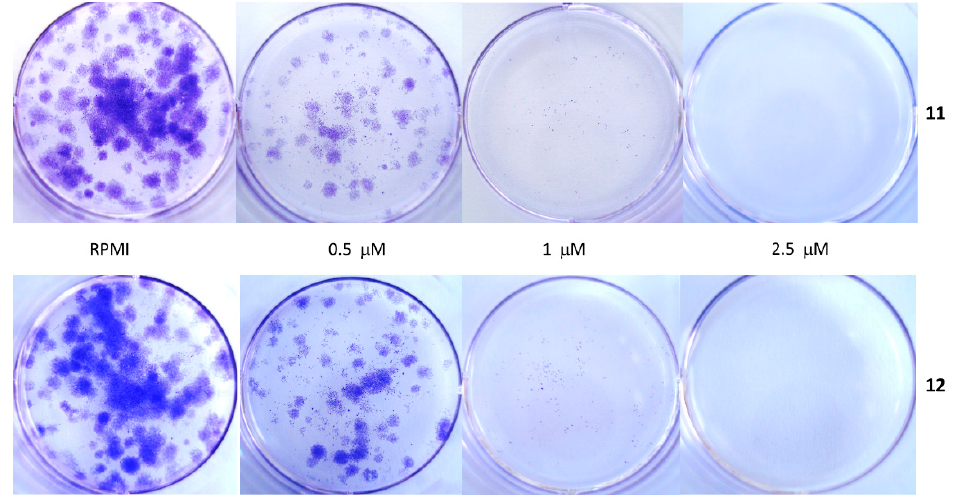
Figure 4. Clonal growth inhibition. Effects of 11 and 12 on the clonal growth of SK melanoma cells. Cells were suspended in a medium containing the indicated increasing concentrations of 11 and 12 for 4 h and then washed, seeded with a drug-free medium in a 12 well-plate, and grew up over 14 days. Cell colonies were stained with crystal violet, counted, and photographed as described [30].